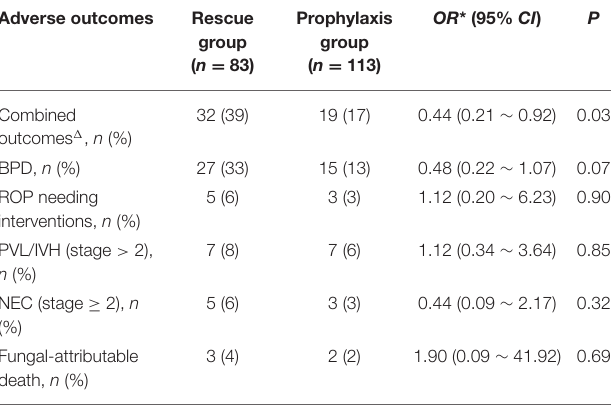
TABLE 5 | The incidences of short-term adverse outcomes between two groups. Adverse